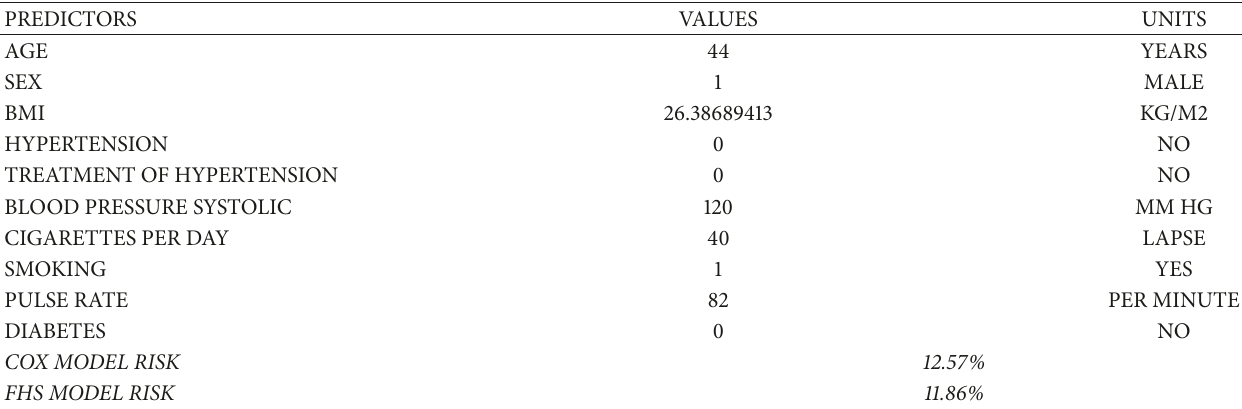
Table 12: Data summary for the subject